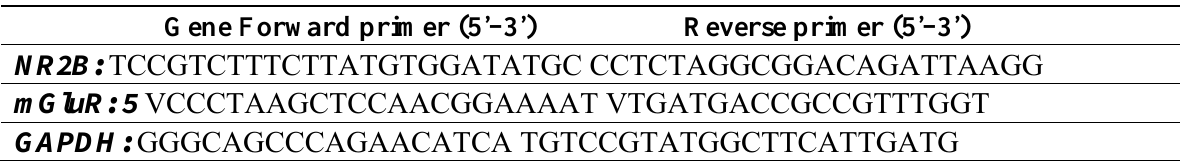
Table 2. Primer sequences used for real-time RT-PCR.